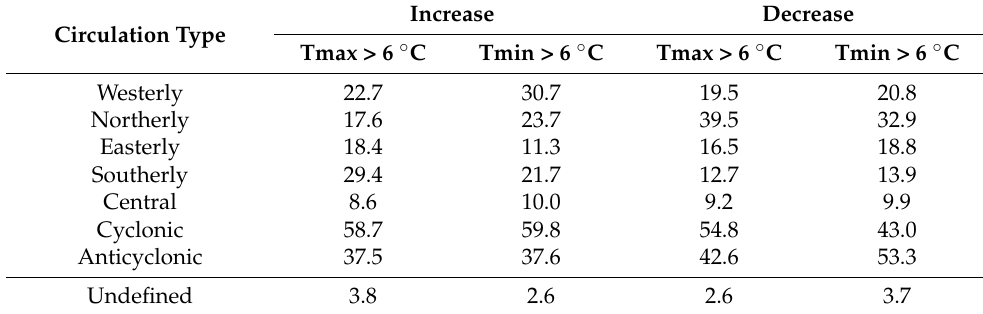
Table 3. Frequency (%) of the occurrence of large interdiurnal extreme air temperature changes in the particular GWL circulation types in the years 1966–2015. For explanations of the circulation types, see Table 2.